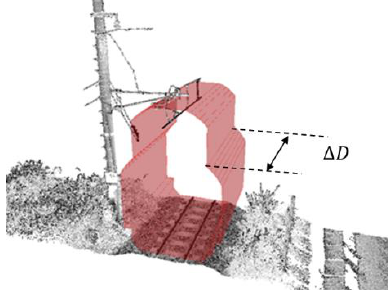
Figure 4. The image of automatic clearance check